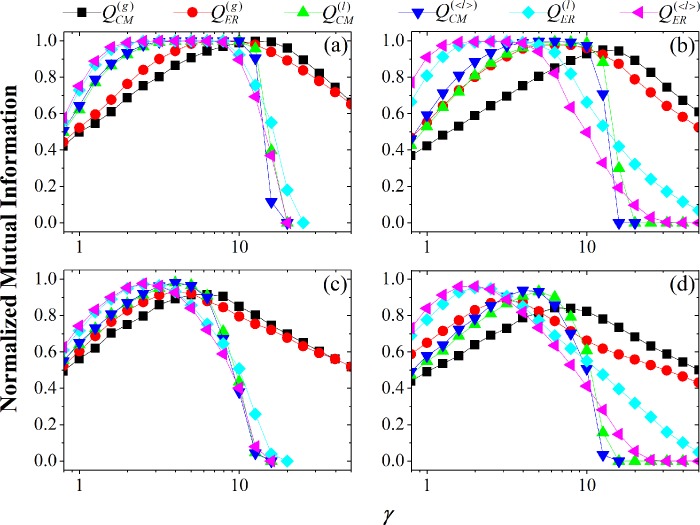
NMI of different methods as a function of γ in the NET4 networks with different heterogeneity of degree and community size (i.e., different values of kmax and cmax).Parameters of networks: (a) kmax=30, cmax=150; (b) kmax=100, cmax=150; (c) kmax=30, cmax=600; (d) kmax=100, cmax=600. (see Table 1 for details of network parameters).